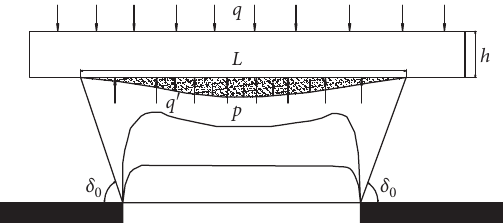
Figure 3: Schematic diagram of the stress model of separation grouting backfill. q is the load density of the main critical layer; p is the supporting force of backfill on the main key layer; q ′ is the vertical compressive stress of backfill to the lower rock